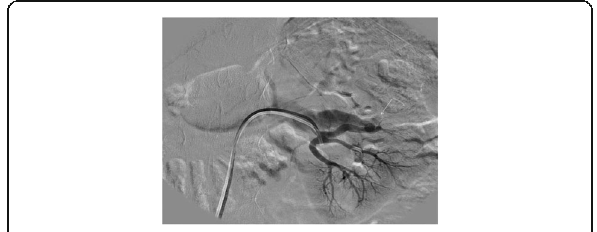
Fig. 1 AVF treatment. High-flow fistula angiography (arrow)